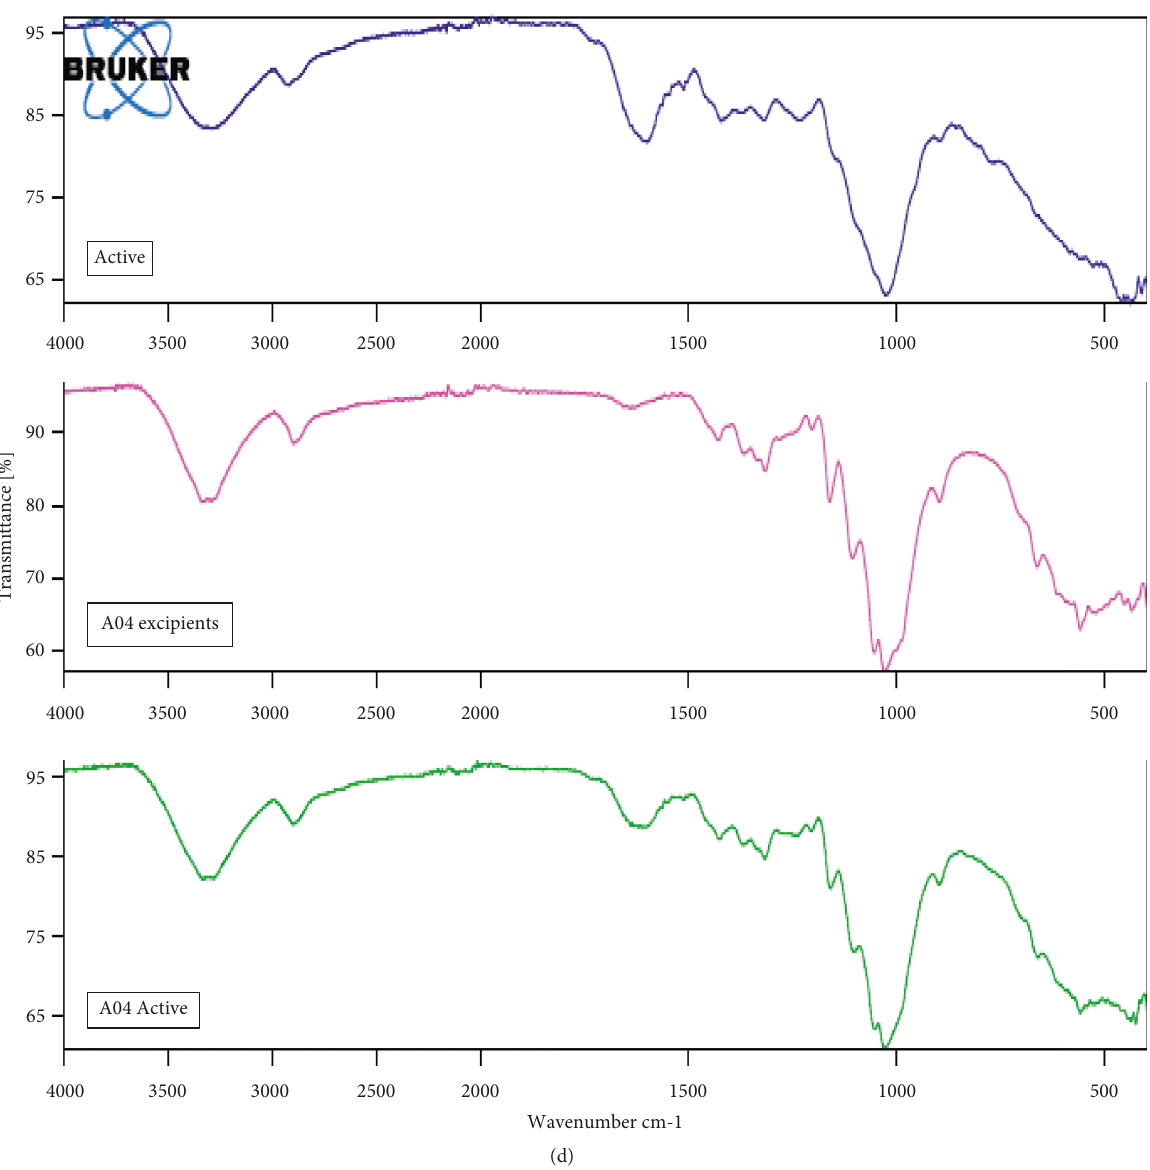
Figure 3: (a) FT-IR spectra of the aqueous extract of the stem bark of Antiaris africana (active), excipients used in formulation A01 (A01 excipients), and the mixture of extract and excipients used in A01 formulation (A01 active) showing no extract-excipient interaction. (b) FT- IR spectra of the aqueous extract of the stem bark of Antiaris africana (active), excipients used in formulation A02 (A02 excipients), and the mixture of extract and excipients used in A02 formulation (A02 Active) showing no extract-excipient interaction. (c) FT-IR spectra of the aqueous extract of the stem bark of Antiaris africana (active), excipients used in formulation A03 (A03 excipients), and the mixture of extract and excipients used in A03 formulation (A03 active) showing no extract-excipient interaction. (d) FT-IR spectra of the aqueous extract of the stem bark of Antiaris africana (active), excipients used in formulation A04 (A04 excipients), and the mixture of extract and